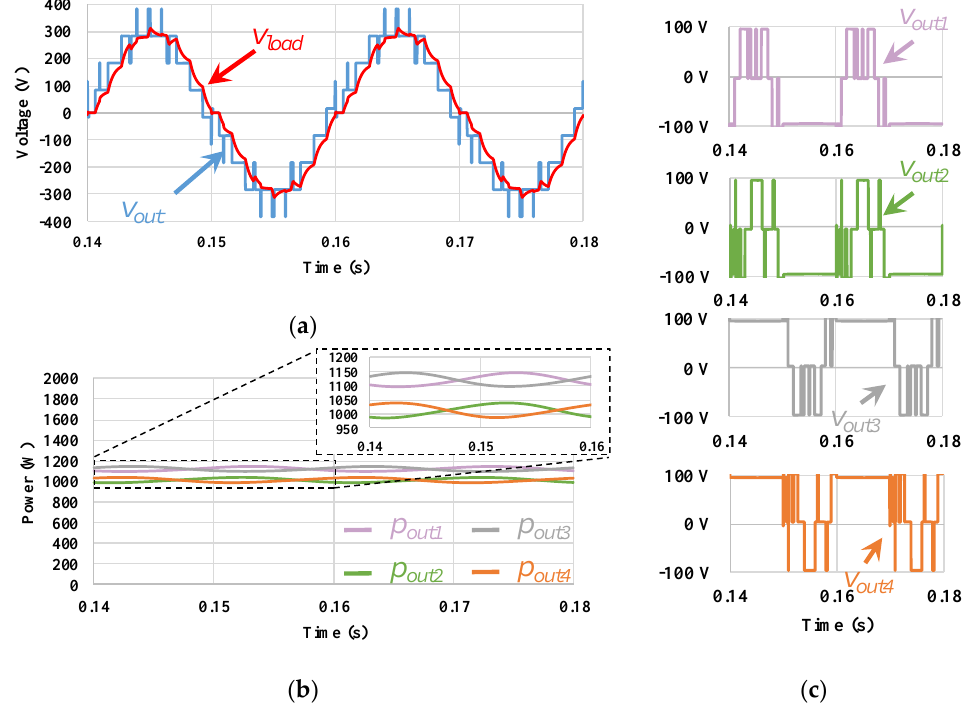
Figure 17. Simulation results of the balanced POD PWM technique: ( a ) output voltage of the cascaded MLC, v out , and load voltage, v load ; ( b ) output power on each submodule ( p out1 , p out2 , p out3 , p out4 ); ( c ) output voltage on each submodule ( v out1 , v out2 , v out3 , v out4 ).